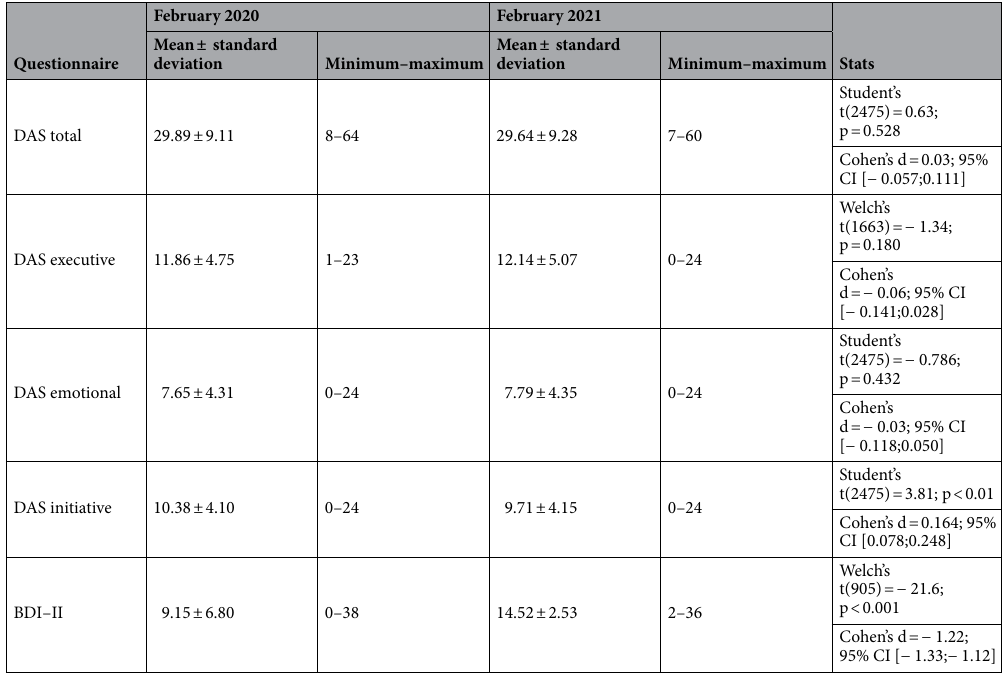
Table 2. Comparison of scores of the validated questionnaires for first-year students, in 2020 and 2021. DAS The Dimensional Apathy Scale (Radakovic and Abrahams 47 ), BDI-II The Beck Depression Inventory II (Beck et al. 52